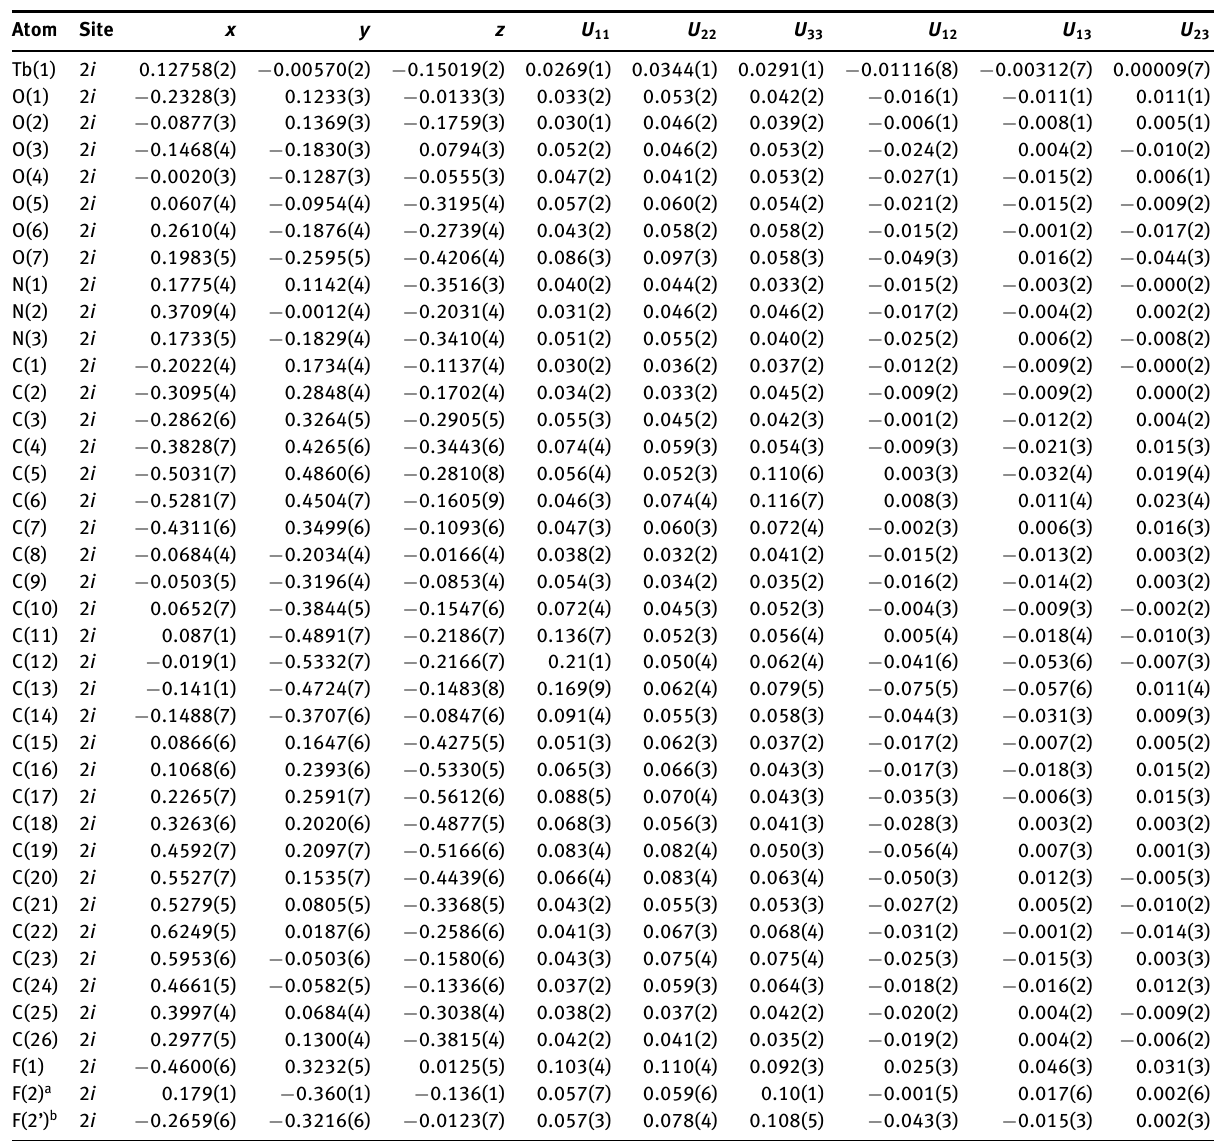
Table 3: Fractional coordinates and atomic displacement parameters (Å 2